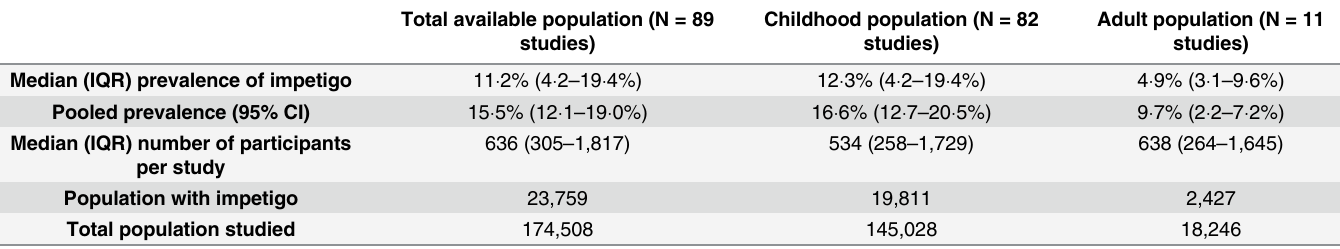
Table 2. Summary statistics of available studies by age grouping.